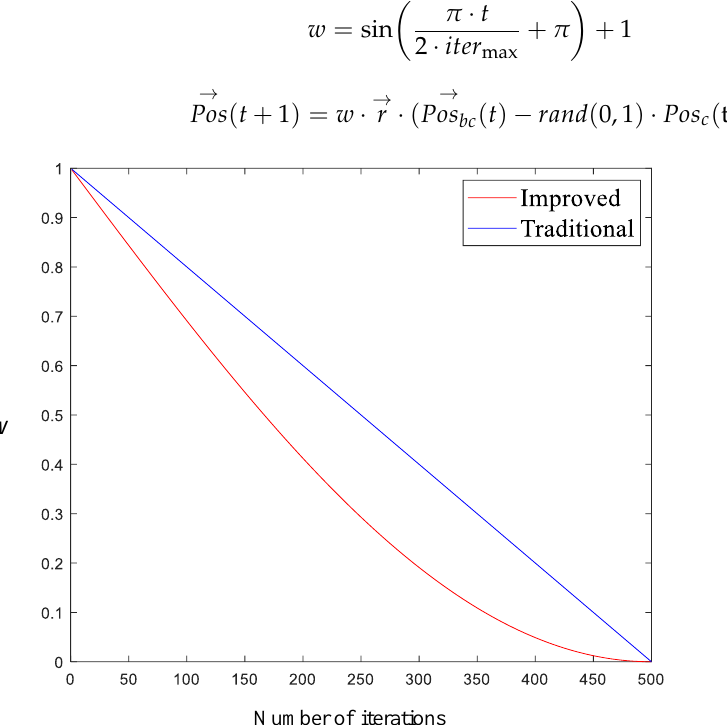
Figure 6. Adaptive weighting curves.